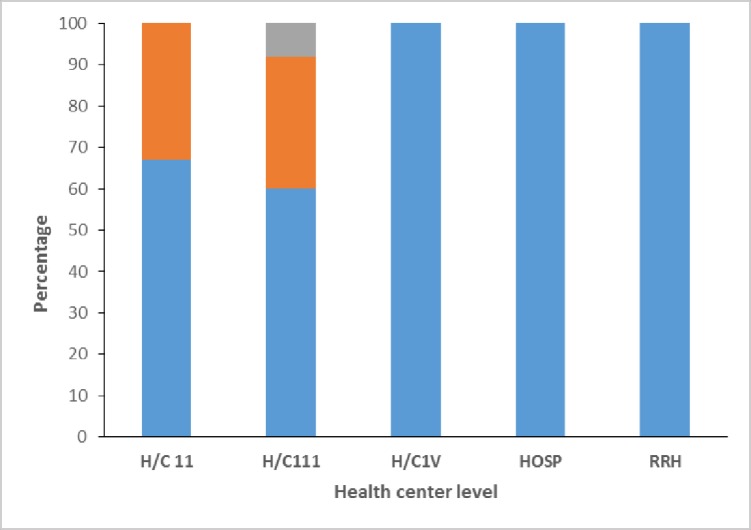
Consistency of DPT-3 vaccination by health center level, from immunization data quality audit, Kabarole district 2015.